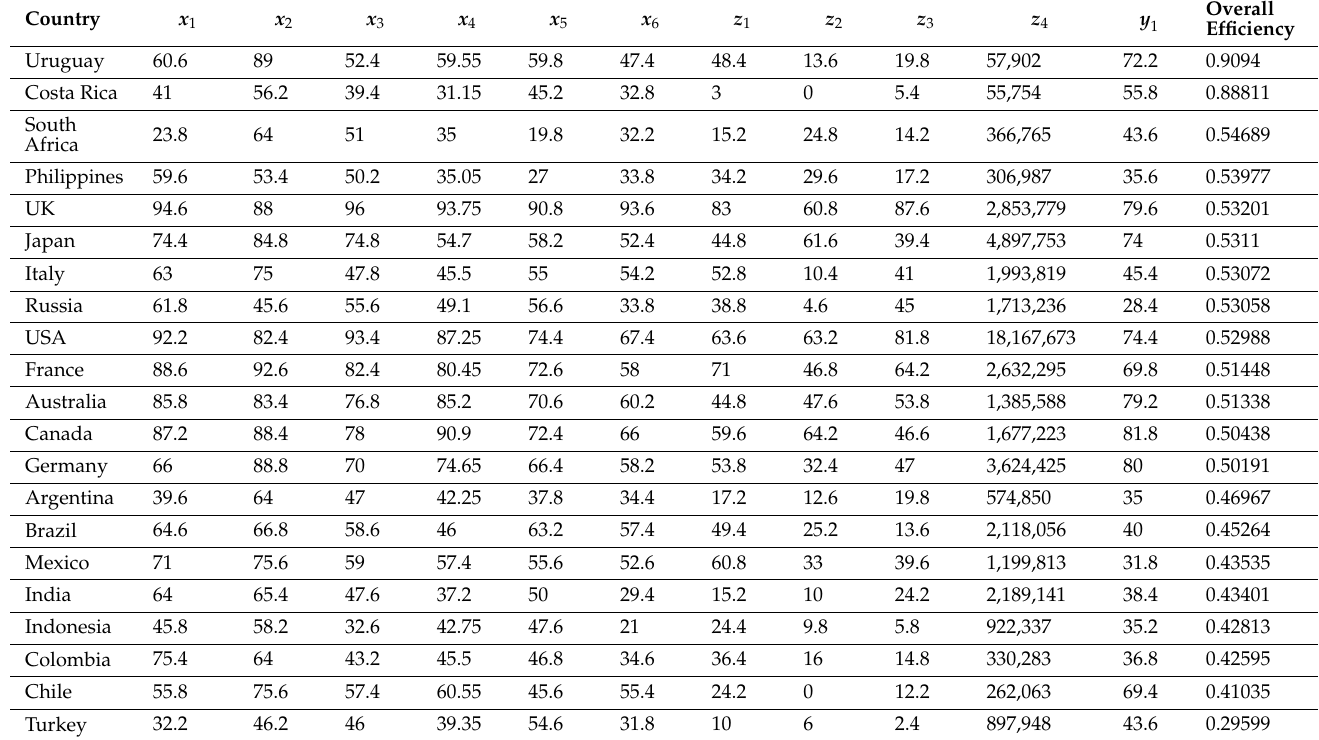
Table 9. Mean of attributes for all years in every